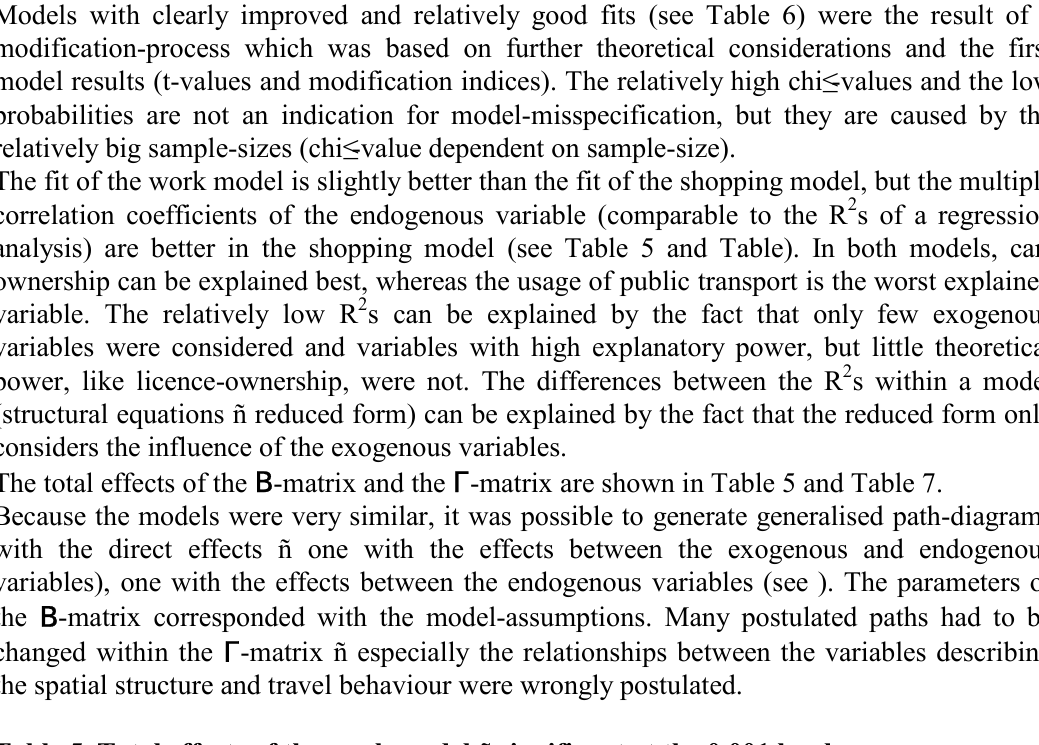
Table 5. Total effects of the work model æ significant at the 0.001 level From